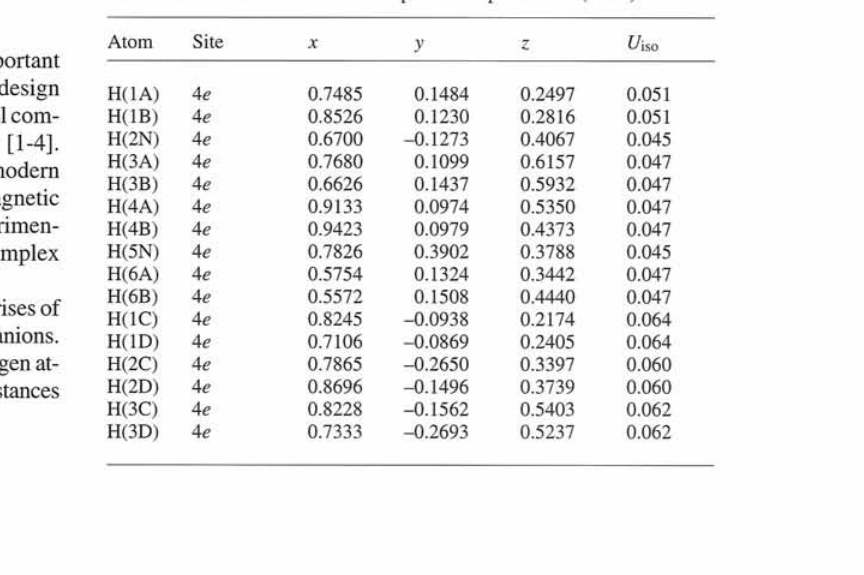
Table 2. Atomic coordinates and displacement parameters (in